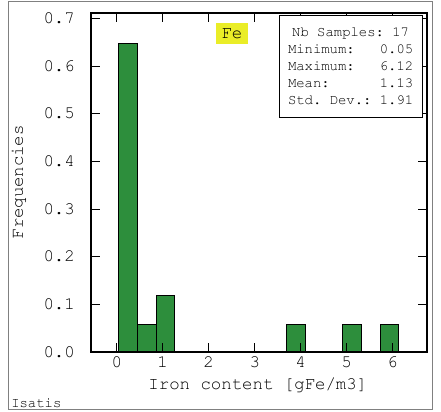
Fig. 3. Histogram of distribution of iron Fe ++ content [g Fe ++ /m 3 ] in underground water for water intake area of Kłodzko (SW part of Poland); data coming from 14 wells + 3